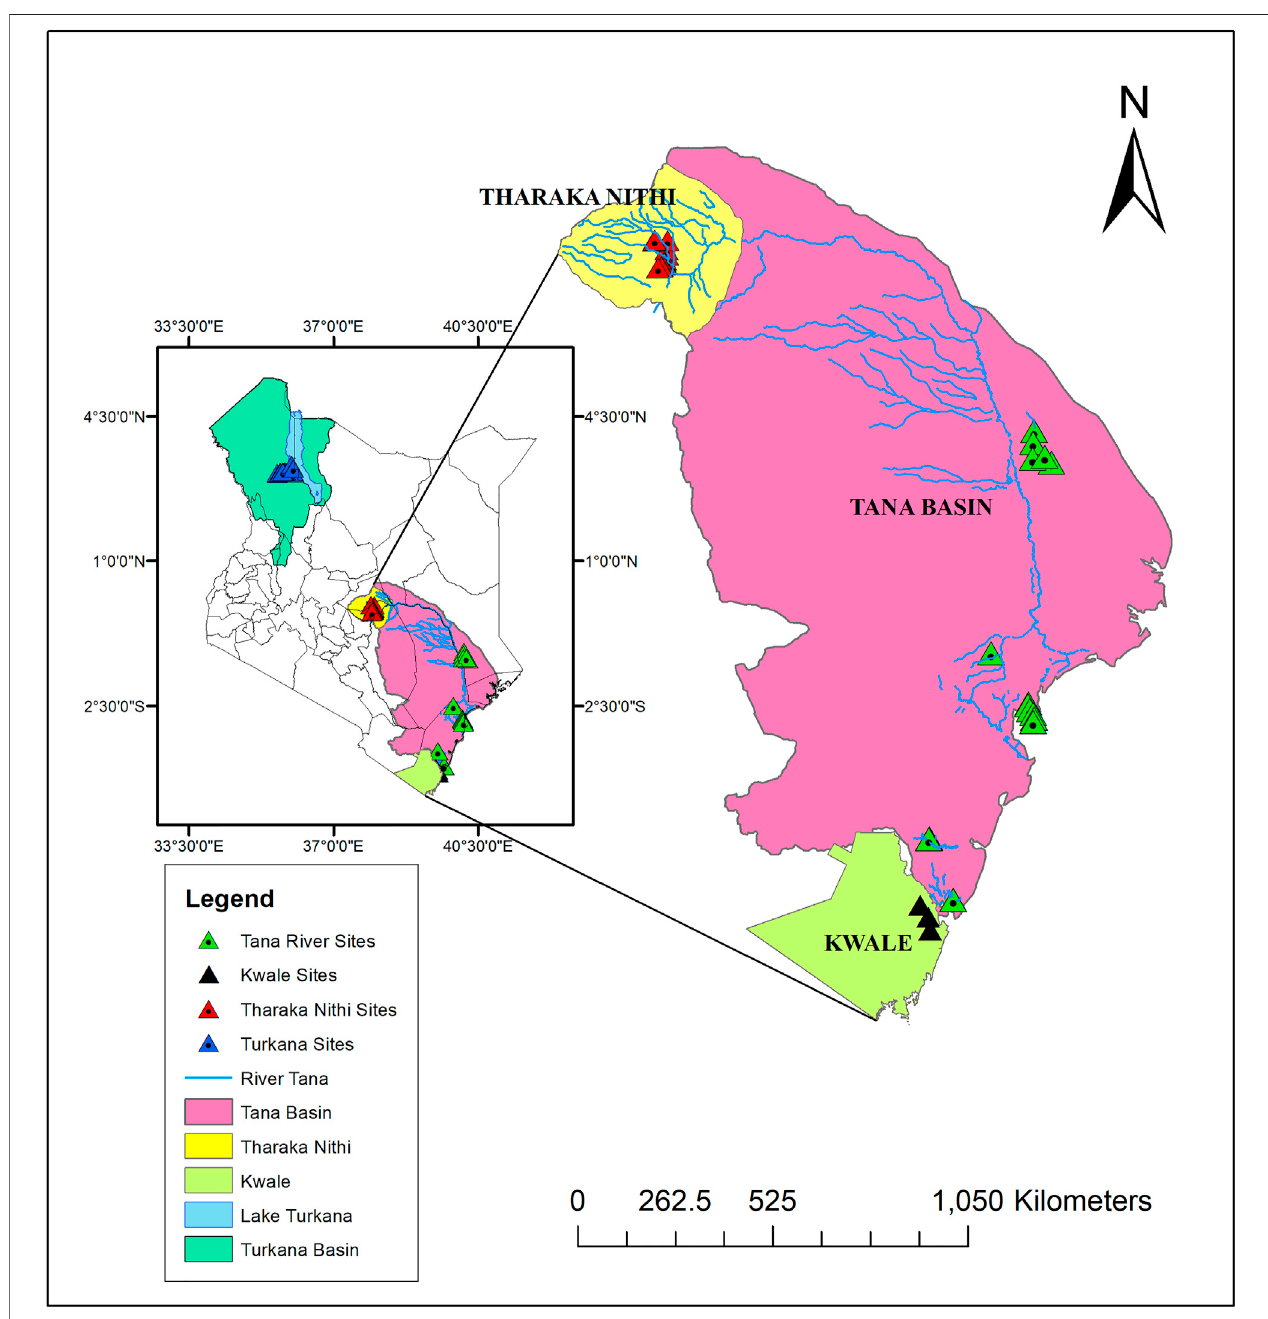
FIGURE 1 | Map illustrating H. compressa sampling points along the Turkana and Tana basins. Map was created using ArcMap version 10.8.